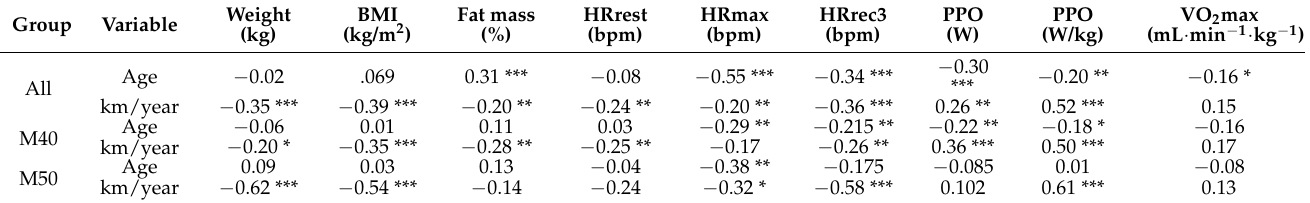
Table 3. Spearman’s rank correlation coefficients between body composition and cardiovascular fitness variables and age and km/year in all groups.